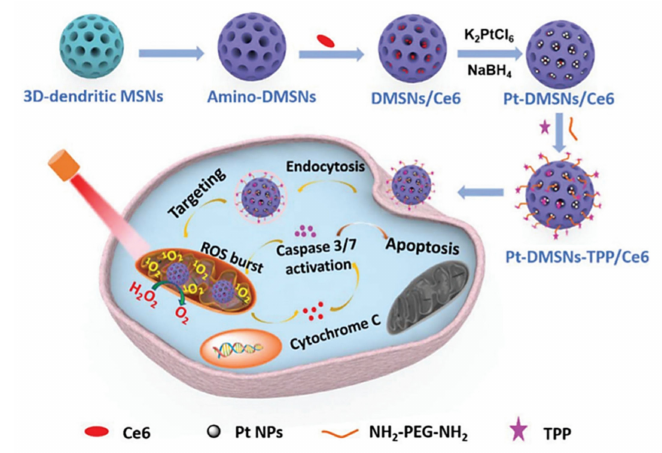
Figure 3. Schematic representation of mitochondria-targeted dendritic MSNs for photodynamic therapy. MSNs were functionalized with triphenylphosphonium (TPP) for mitochondrial targeting and loaded with the photosensitizer Ce6. Then, Pt nanoparticles showing peroxidase-like nanozyme activity were attached to the surface to catalyze the conversion of intracellular H 2 O 2 into oxygen in the tumoral cells. Finally, Ce6 generated ROS upon light irradiation, leading to synergistic cell death. Reproduced from Ref. [78] with permission from The Royal Society of